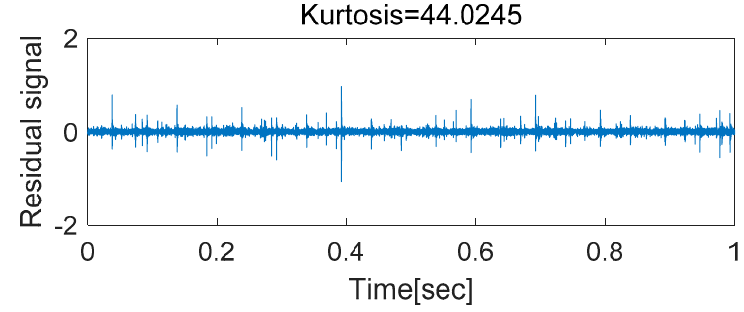
Figure 14. Residual signal after the AR filtering.